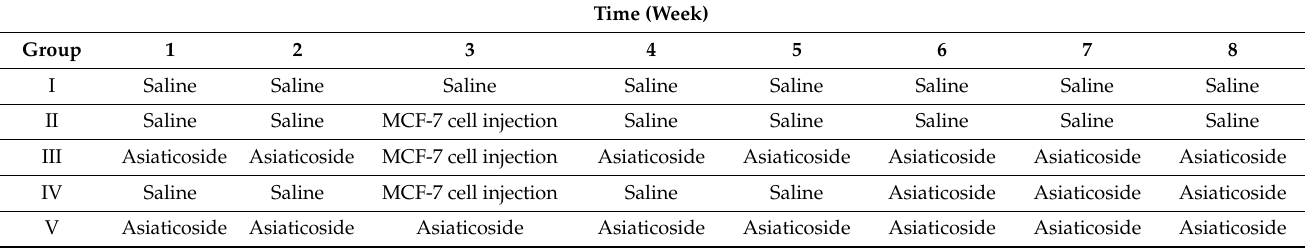
Table 3. The mice were injected with a dose of 150 mg/kg asiaticoside (0.5 mL) intraperitoneally.